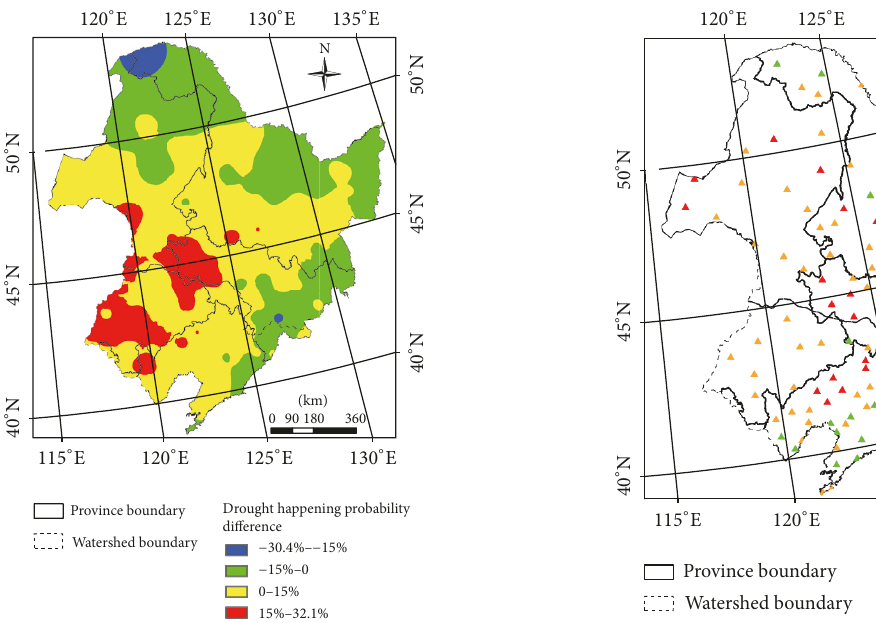
Figure 10: Spatial distribution of drought happening probability difference between 1964–1994 and 1995–2013 (1995–2013 minus 1964–1994) over the SLRB.